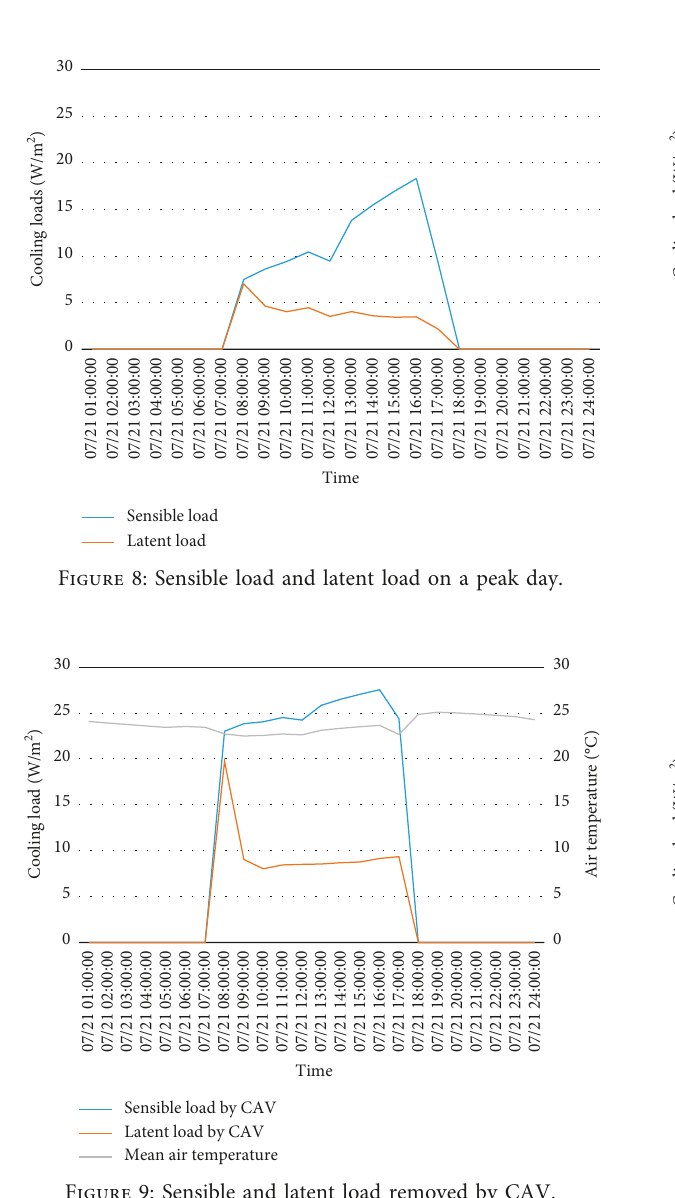
Figure 11: Sensible and latent load removed by